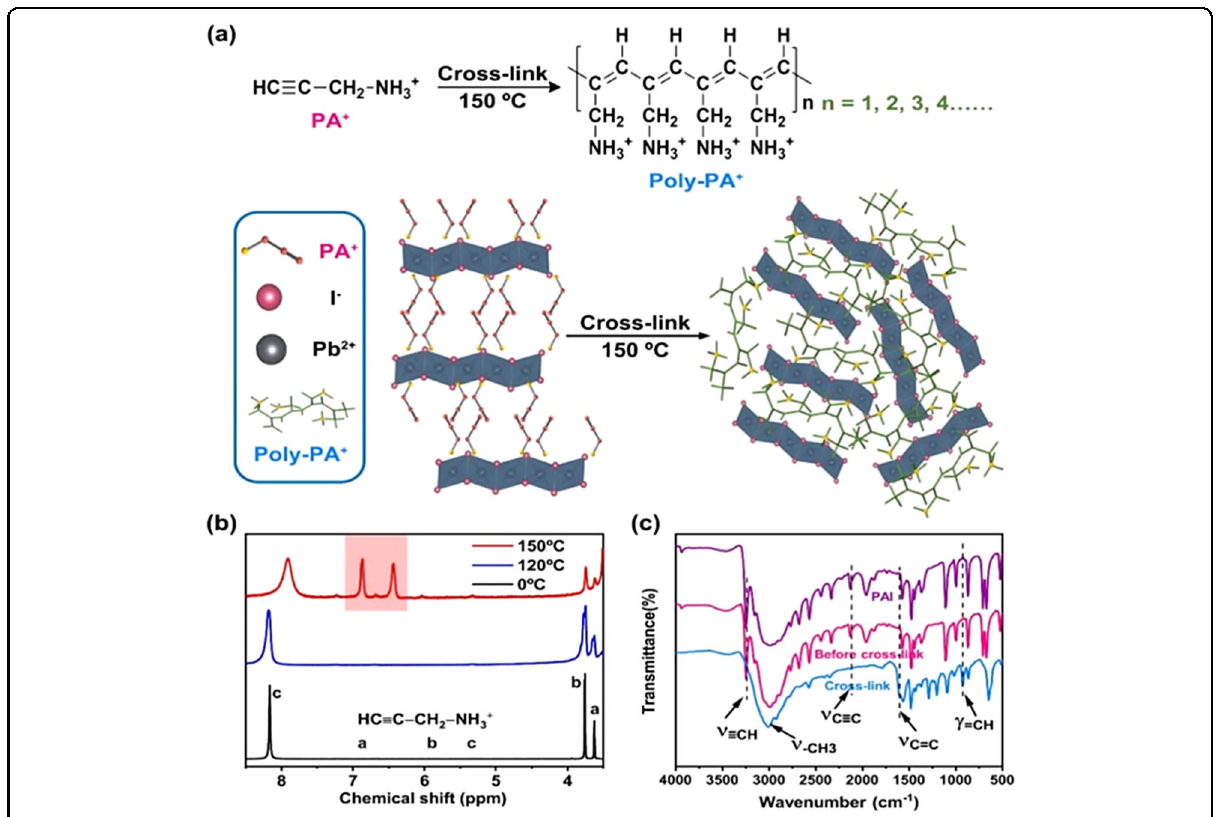
Fig. 11 Formation of 1D/3D hetero-structure via cross-linking of PA. a Cross-linking of PA + itself and in 1D “ perovskitoids ” . b Proton nuclear magnetic resonance (H-NMR) spectra obtained for PAI powders before and after cross-linking. c Fourier transform infrared (FTIR) spectra obtained for pure PAI and for 1D/3D fi lms before and after cross-linking. Reproduced with permission from ref. 135 . Copyright 2020, the Royal Society of